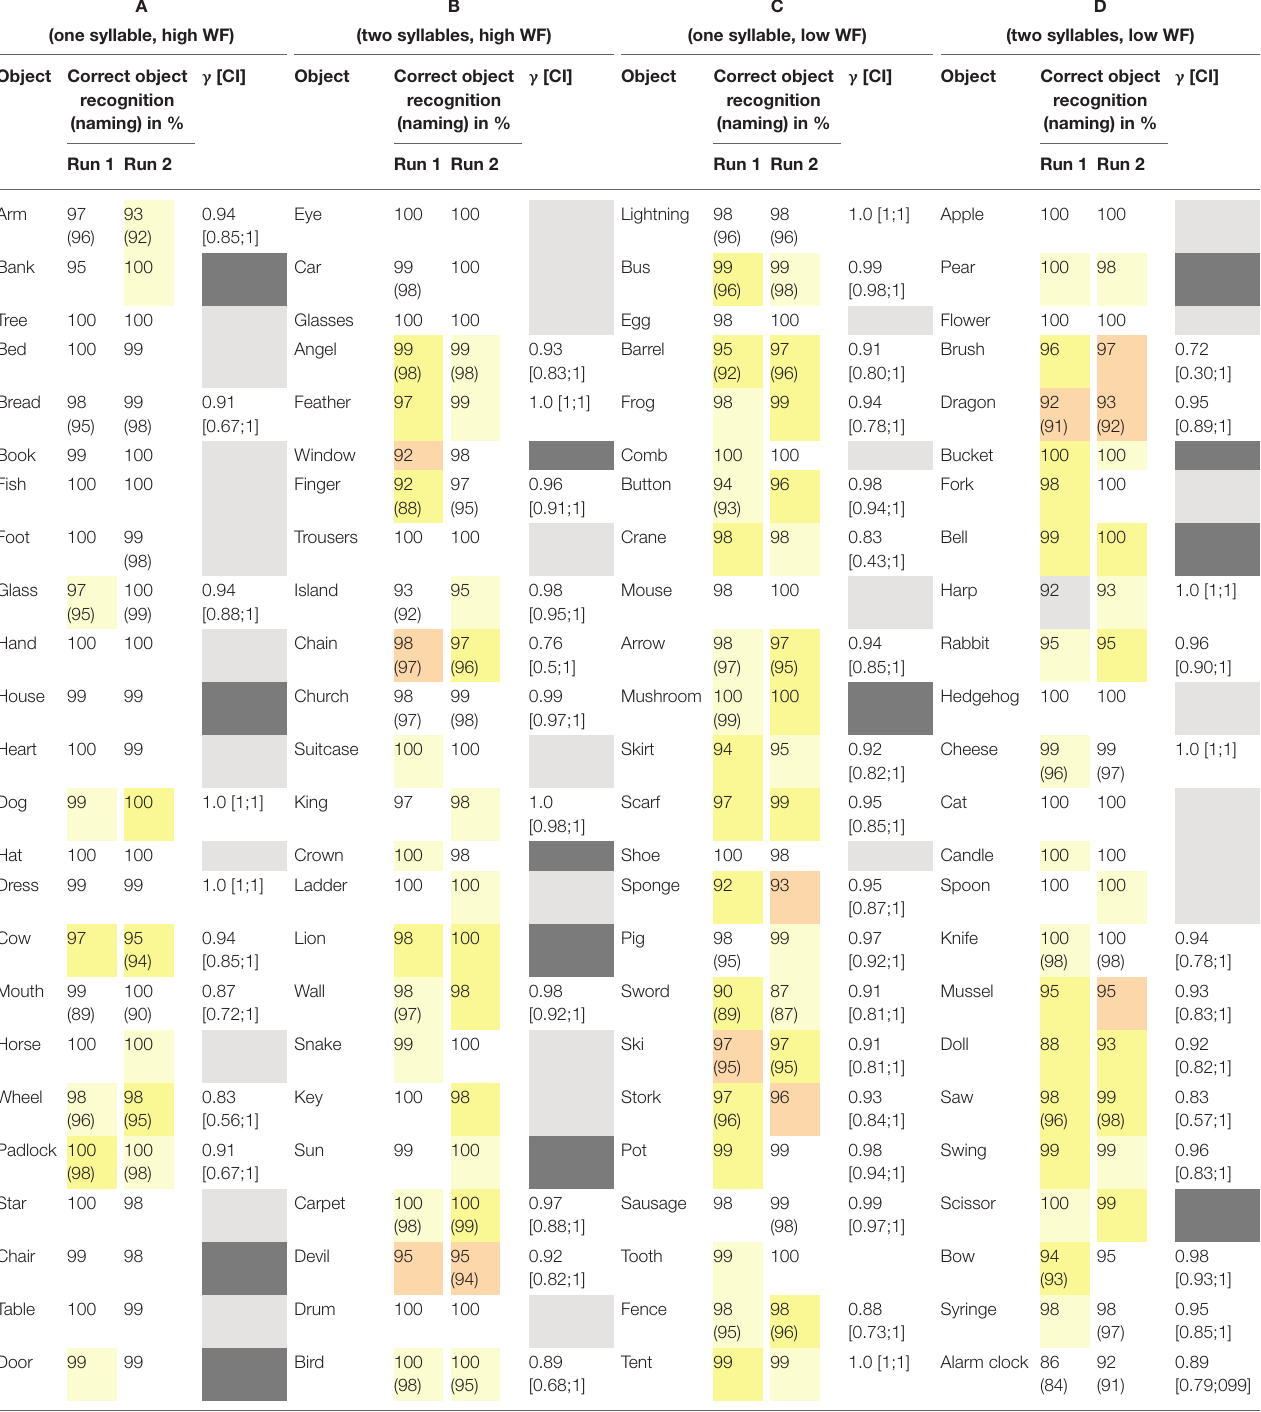
TABLE 5 | Object recognition rates and naming reliability by